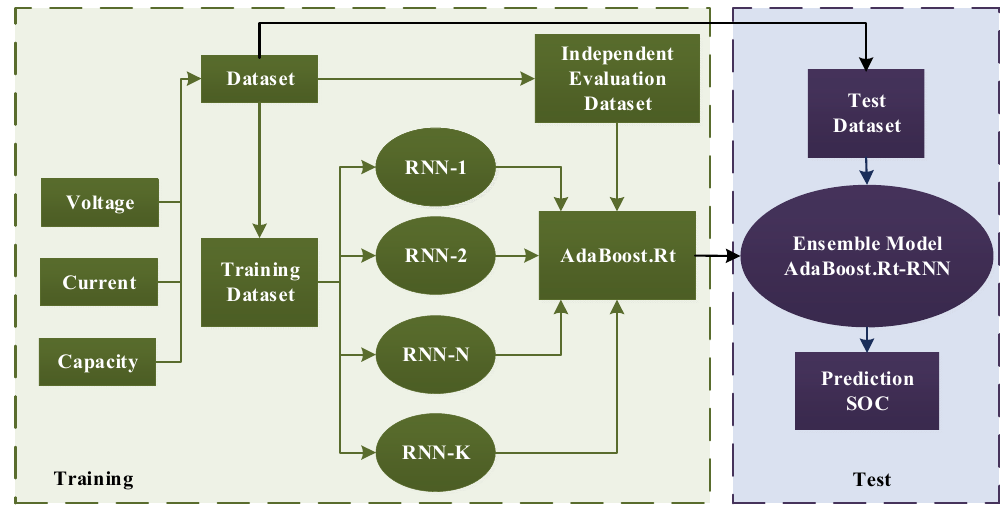
Figure 5. Schematic diagram of AdaBoost.Rt-RNN algorithm.